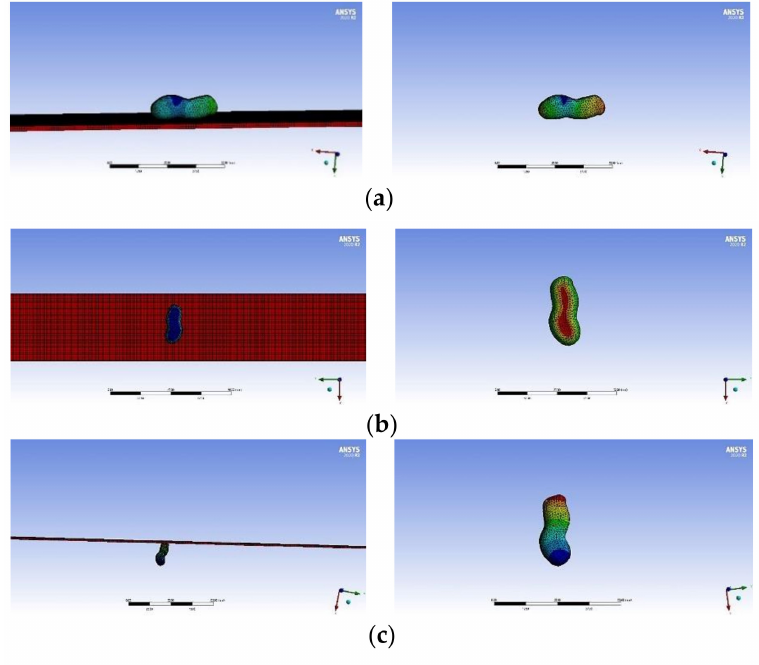
Figure 9. Simulation process of peanut pod collision. ( a ) Lateral collisions; ( b ) Longitudinal collisions; ( c ) Vertical